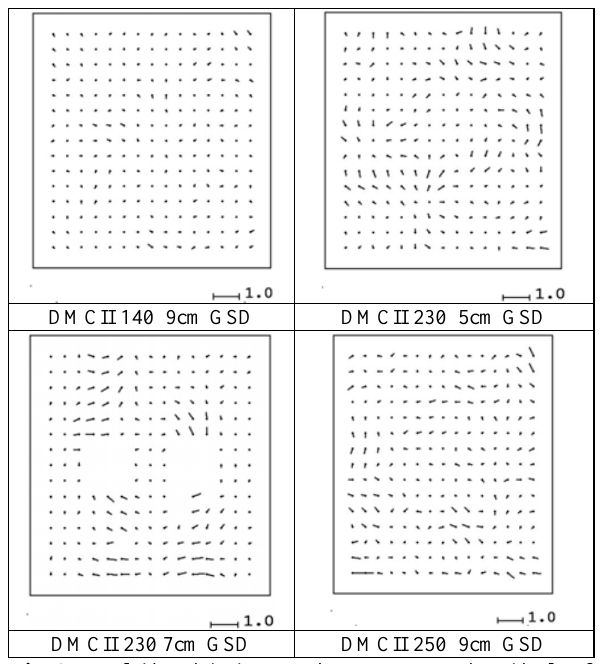
Fig. 6: overlaid and in image sub-areas averaged residuals of bundle block adjustments with parameters 1 - 12